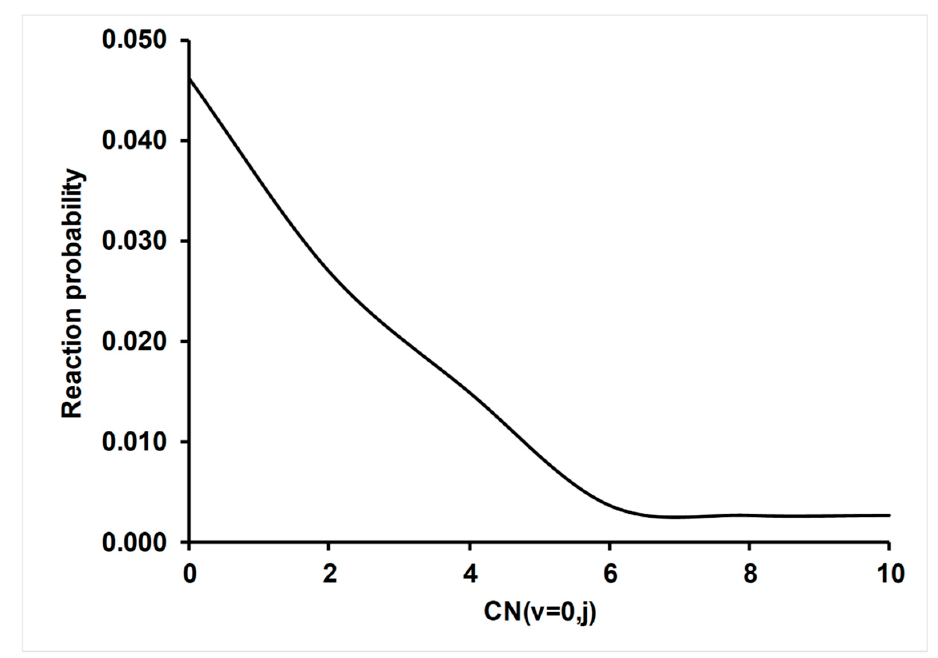
Figure 5. Reaction probability, P r =N r /N T , as a function of the rotational quantum number, j, in the CN (v = 0,j) reactant. Theoretical results at T = 300 K using the QCT/PES-2020